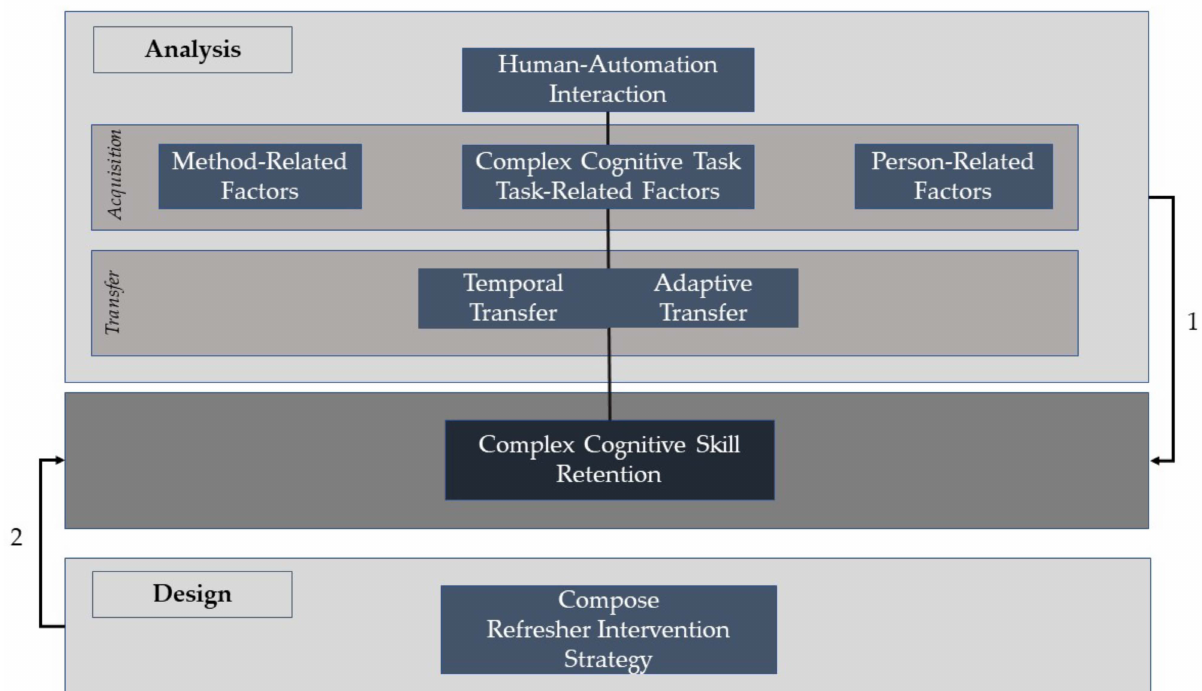
Figure 1. Graphical representation of the focuses and aims of this scoping